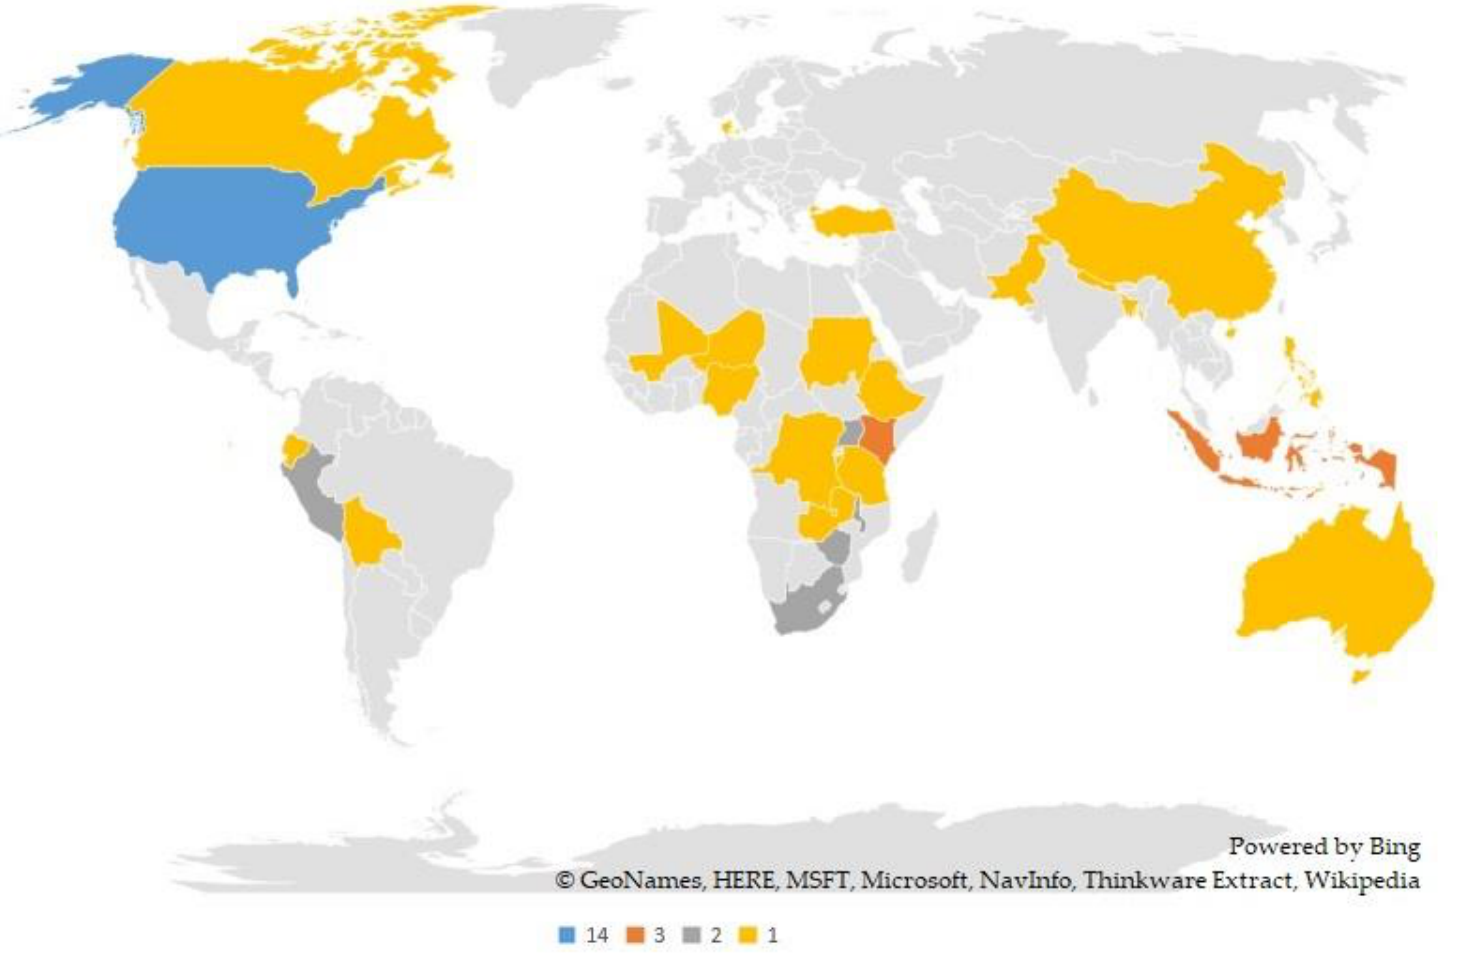
Figure 4. Distribution of publications on food security and social capital in di ff erent